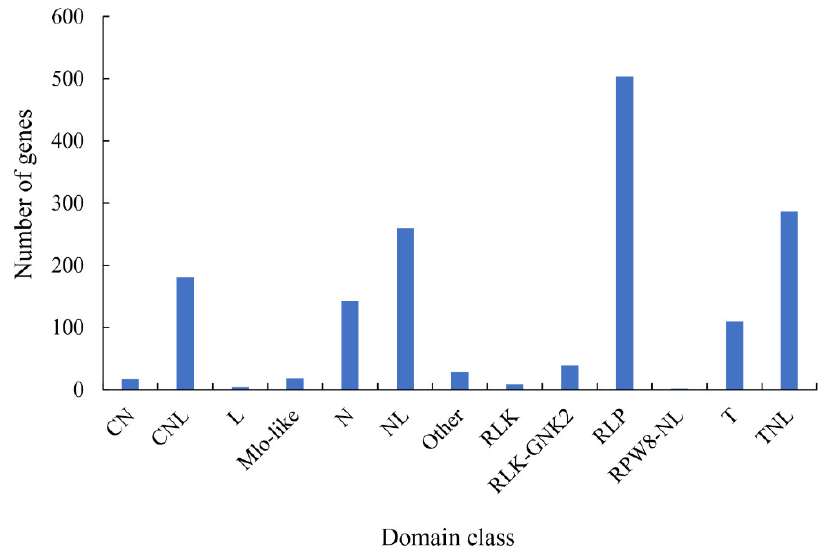
Figure 5. Domain class identification of DEGs annotated as pathogen-related genes (PRGs). Class descriptions available online (http://prgdb.crg.eu/wiki/Category:Classes, accessed on 3 June 2021).